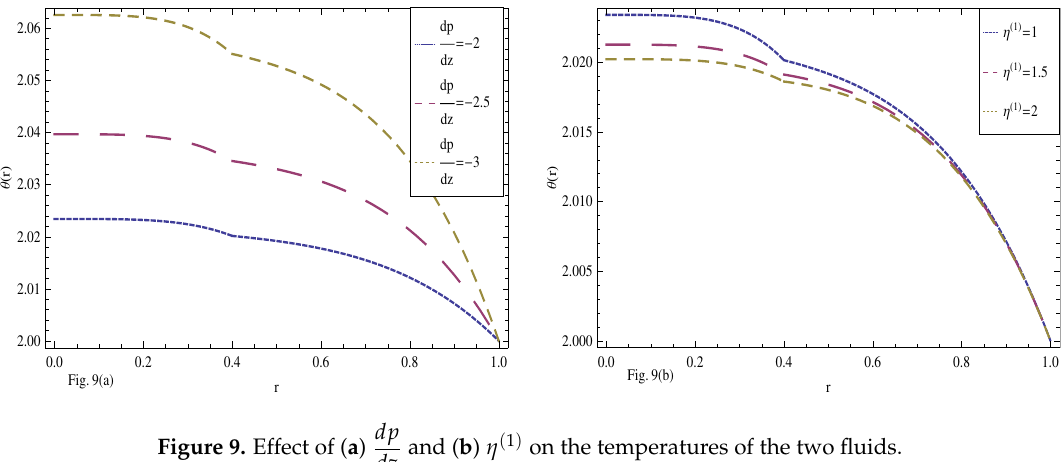
Figure 9. Effect of ( a )